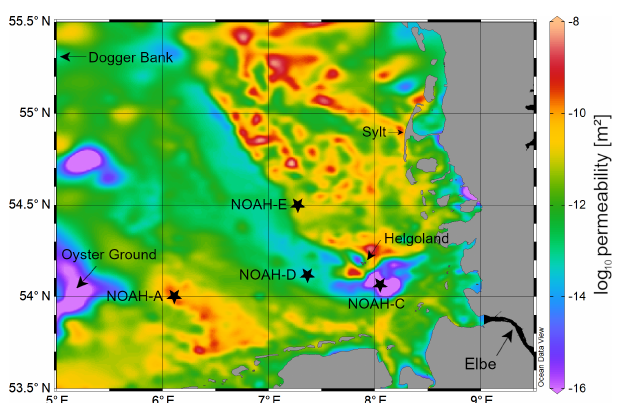
Figure 1. Map showing the sampling stations NOAH-A, NOAH- C, NOAH-D and NOAH-E in the German Bight in the North Sea. Colored areas show the spatial variability in surface sediment per- meability (https://doi.org/10.1594/PANGAEA.872712, last access: